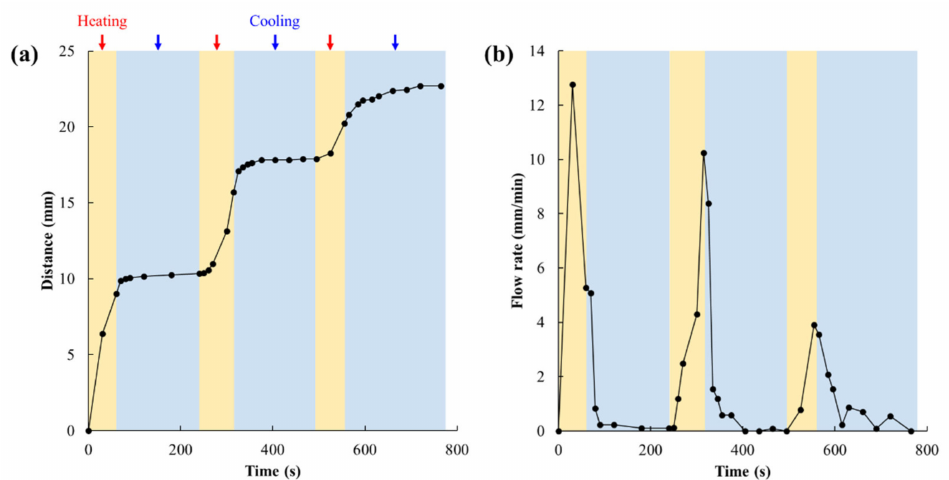
Figure 10. Flow behavior when the proposed valve is repeatedly opened and closed. ( a ) Distance of the wetting front of the green colored water in the upper channel and ( b ) its flow velocity. The distance traveled by the wetting front of the green colored water in the upper channel was measured every 10 to 30 s ( a ), and flow velocity was calculated from the difference between the distance traveled at a point and distance traveled at the previous measurement point ( b ). Orange-shaded areas indicate heating above 32 ◦ C, and blue-shaded areas indicate cooling below 32 ◦